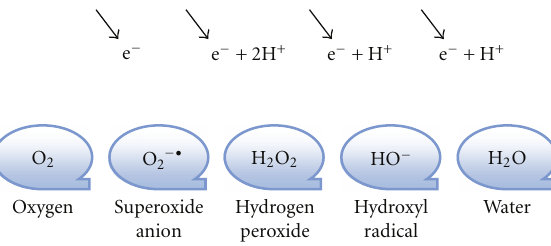
Figure 1: Reduction of oxygen. A single-electron transfer which converts molecular oxygen to the superoxide anion, creating an un- stable molecule. The decomposition of hydrogen peroxide can be a source of the hydroxyl radical; this reaction requires both super- oxide and hydrogen peroxide as precursors. These steps reduce oxy- gen to water by the addition of four electrons, yielding three reactive oxygen species: superoxide anion, hydrogen peroxide, and hydroxyl